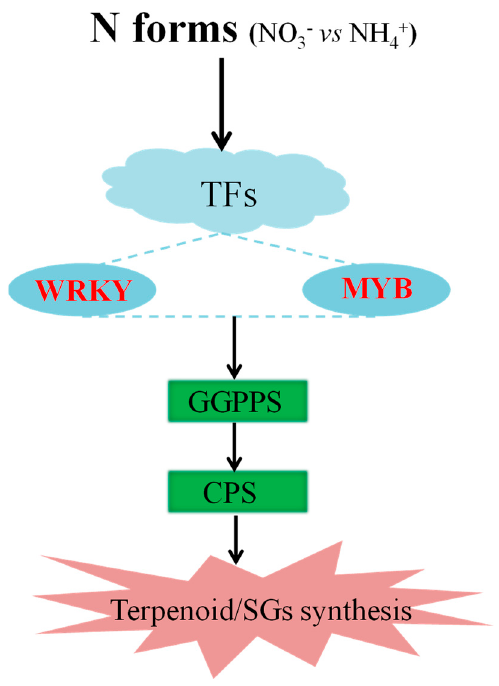
Figure 8. A schematic model showing the regulation of steviol glycosides synthesis by N forms- MYB/WRKY-GGPPS/CPS in stevia leaves. When feeding with nitrate nitrogen (N-N) rather than ammonium nitrogen (A-N), specific transcription factors in stevia leaves, especially those belong- ing to MYB and WRKY families, are activated. Theses TFs can regulate the expressions of terpene synthesis-related genes such as GGPPS and CPS, thereby promoting the production of steviol gly-